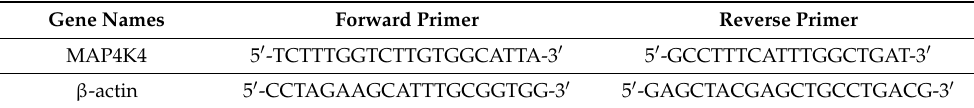
Table 2. All primer sequences of